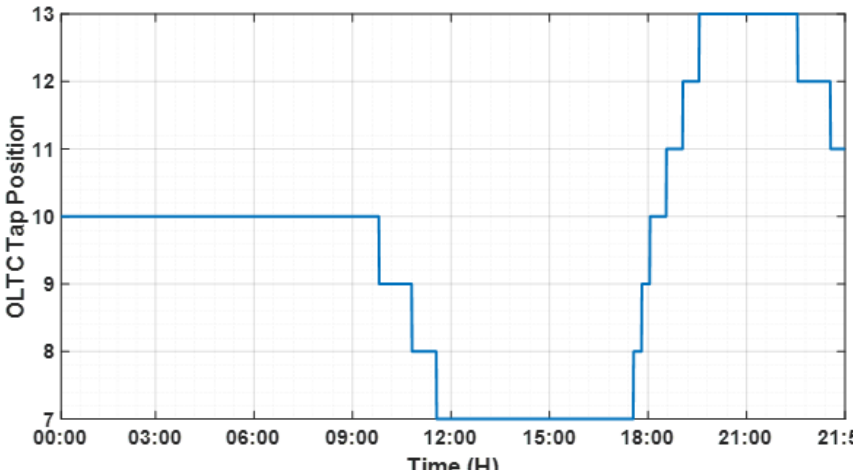
Figure 17. OLTC tap position.